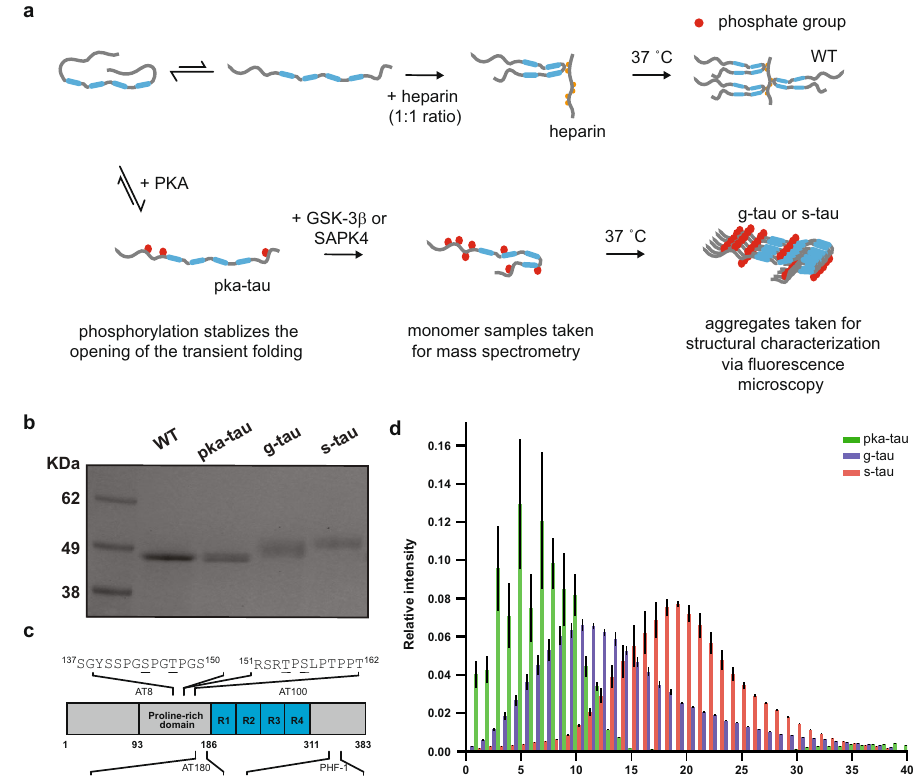
Fig. 1 Sequential hyperphosphorylation of tau in vitro generates AD-speci fi c epitopes. a A pictorial representation of the experimental design: WT tau was sequentially hyperphosphorylated, fi rst by PKA and then by either GSK-3 β or SAPK4 kinase. Hyperphosphorylation is shown to be able to cause an opening of such transient paperclip conformation 50 and simultaneously stabilizes the α -helical structures, which is associated to the aggregation process 51 Recent cryo-EM structures and computational study reveals heparin can stabilize the interaction between R2 and R3 (repeat domain 2 and 3) and hyperphosphorylation lowers the free-energy landscape of R3 and R4 for forming aggregation 15,55 . b Representative SDS-PAGE (4 – 12%, stained by Coomassie blue) across three independent experiments showed an upward shift of electrophoretic mobility for both g-tau and s-tau species, indicating successful phosphorylation reaction. c LC-MS/MS analysis revealed that both g-tau and s-tau tau were hyperphosphorylated at AD-speci fi c epitopes, such as targeting sites of AT8, AT100, AT180, and PHF-1, highlighted along with the pictorial representation of WT tau. d High-resolution native mass spectrometry results indicated on average there were 7 phosphate groups per PKA-tau molecule, 11 phosphate groups per g-tau molecule and over 19 phosphate groups per s-tau molecule. Error bars represent ±s.d. from MCMC